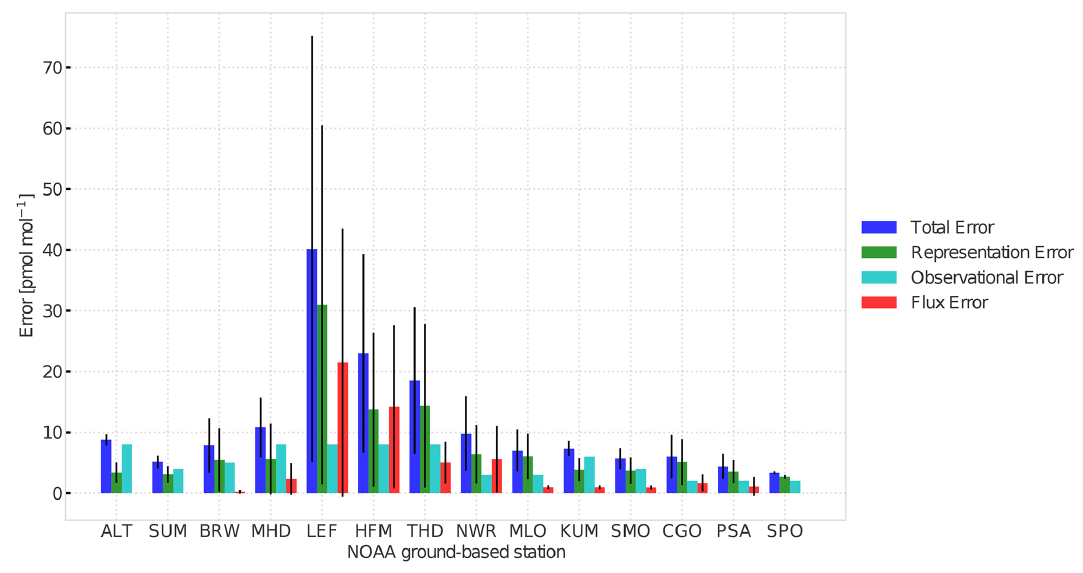
Figure 3. Error analysis for NOAA stations. Black error bars represent the time variations in the errors over a 3-year period (2008–2010). For ALT, SPO and SUM, the flux-related errors are close to zero and not shown. Stations are ordered from the North Pole to the South